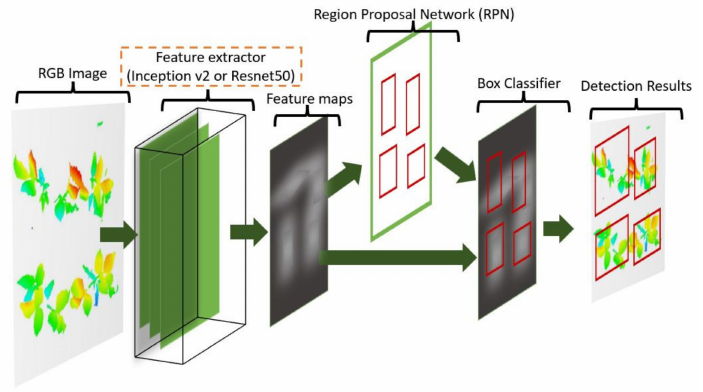
Figure 9. Faster RCNN architecture with Inception-v2 or ResNet50 feature extractor. This architecture uses a region proposal network (RPN) responsible for proposing bounding boxes containing plants. After the training process, the model can detect and label plants on the input